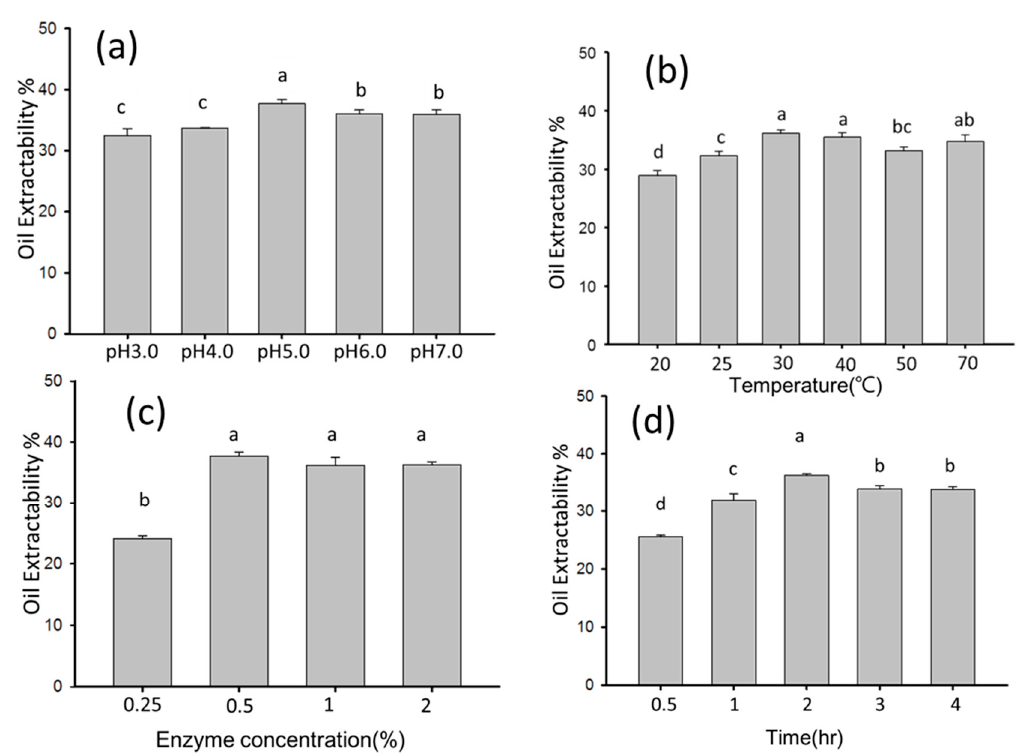
Figure 3. Effect of ( a ) pH, ( b ) temperature, ( c ) enzyme concentration, and ( d ) hydrolysis time on the oil extractability by papain pretreatment. Means with different superscript letters significantly differ ( p < 0.05).